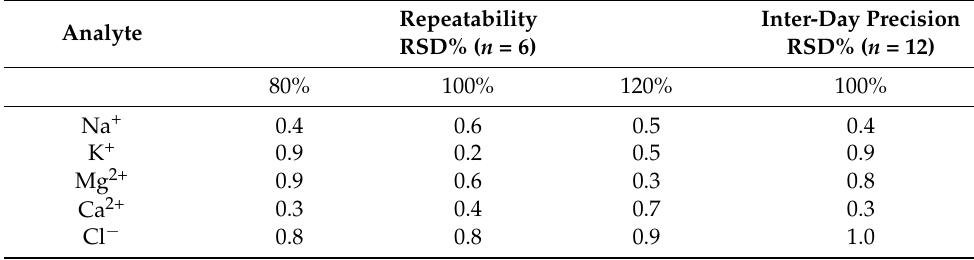
Table 6. Precision of the IC method.